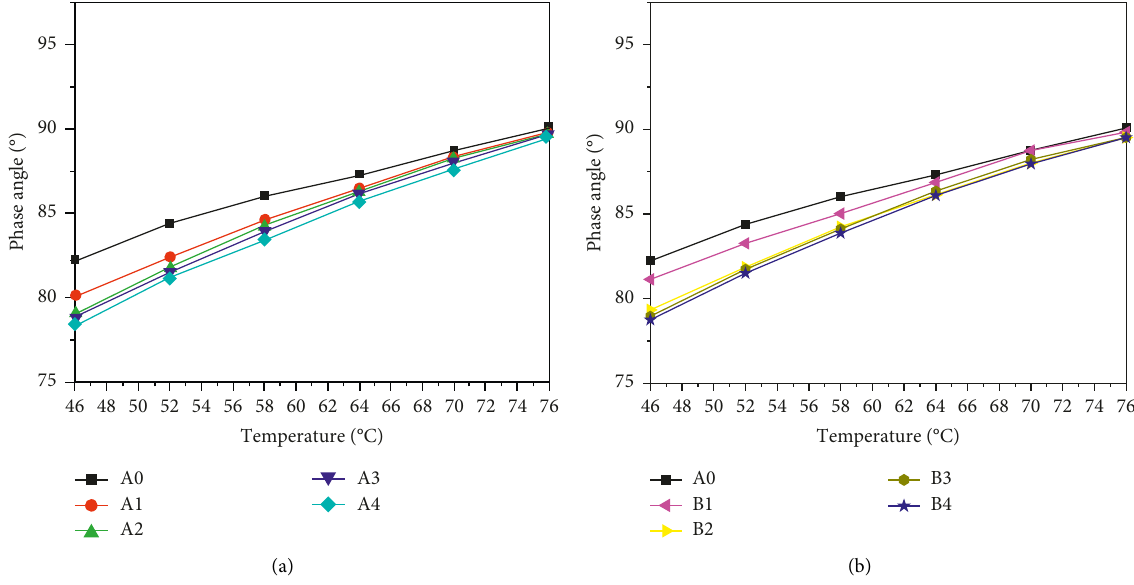
Figure 8: Phase angle of the GOMBA at different dosage levels. (a) Effects of different dosage levels of GO on the phase angle of bio-asphalt A and (b) effects of different dosage levels of GO on the phase angle of bio-asphalt